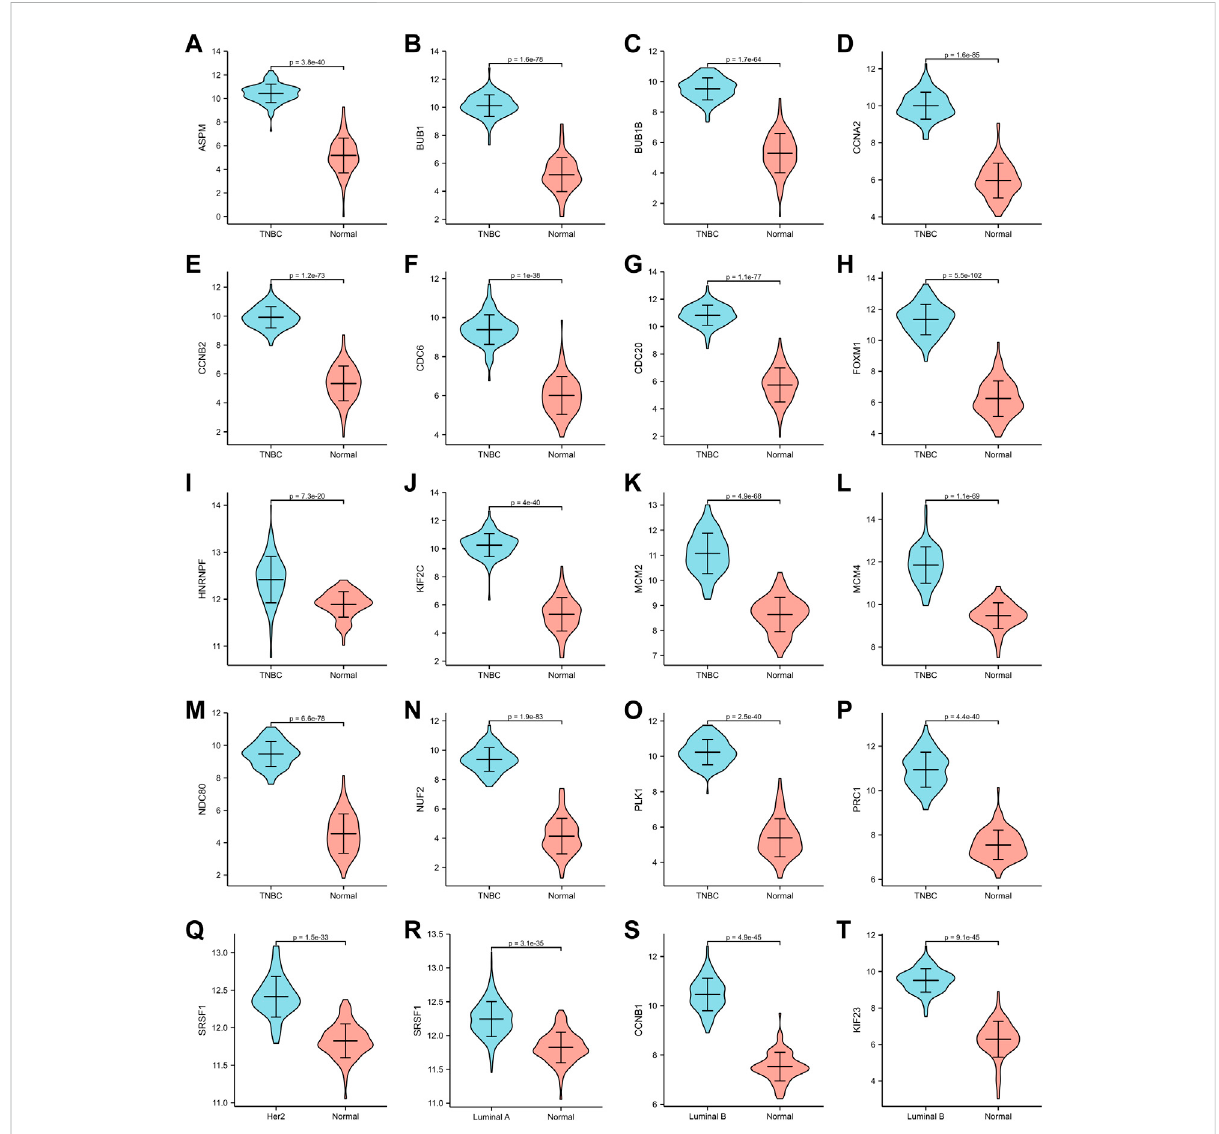
FIGURE 7 Validation of hub genes in TCGA dataset. (A – P) ASPM , BUB1 , BUB1B , CCNA2 , CCNB2 , CDC6 , CDC20 , FOXM1 , HNRNPF , KIF2C , MCM2 , MCM4 , NDC80 , NUF2 , PLK1 , PRC1 expression in TNBC subtype. (Q) SRSF1 expression in Her2 subtype. (R) SRSF1 expression in Luminal A subtype. (S,T) CCNB1, KIF 23 expression in Luminal B